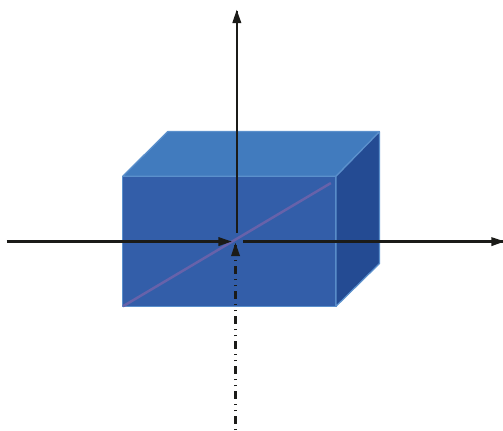
Figure 2: The 50 :50 beam splitter represented by the operator BS in (46). This is a two-channel optical device operating on states |⋅⟩ ⊗ |⋅⟩ , where the ket at the left (right) stands for “horizontal” (“vertical”) signal. The dashed dotted arrow represents classical stateslikethevacuum |0⟩ whilethecontinuousarrowsareassociated with nonclassical states like the number eigenstates |𝑛 + 1⟩